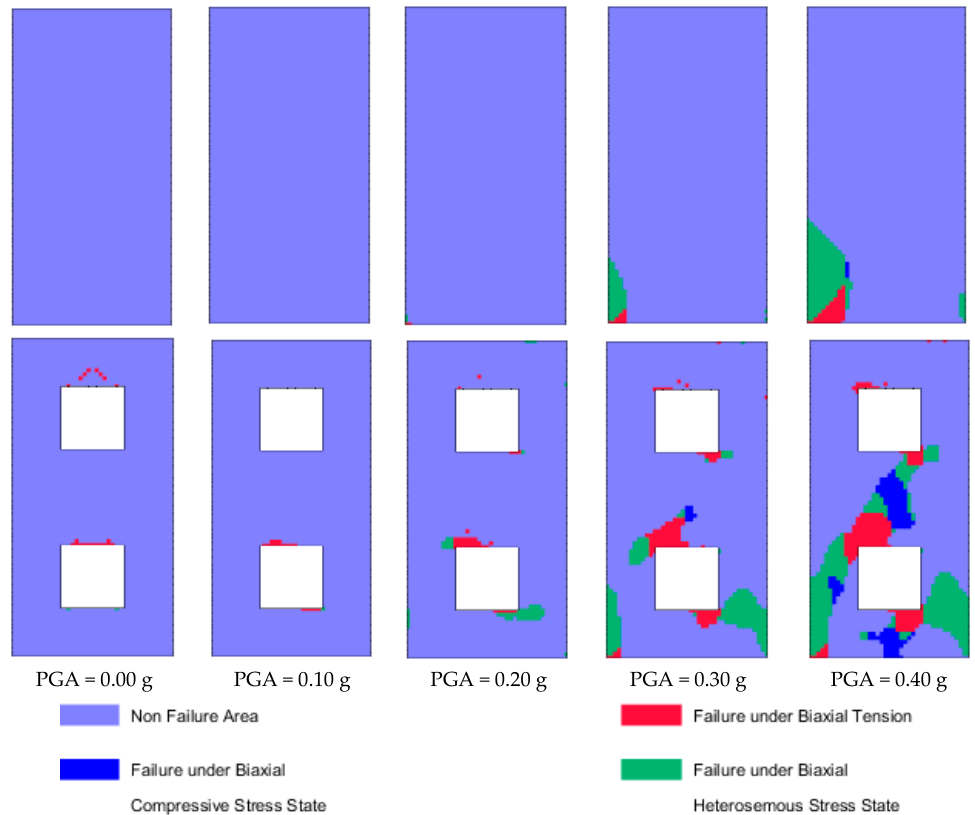
Figure 33. Evolution of the developing failure based on Kupfer and Gerstle’s (1973) failure criterion for values of PGA ranging from 0.00 to 0.40 g by step 0.10 g.